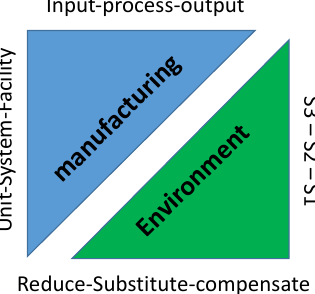
Figure 2. Categorisation outlook.